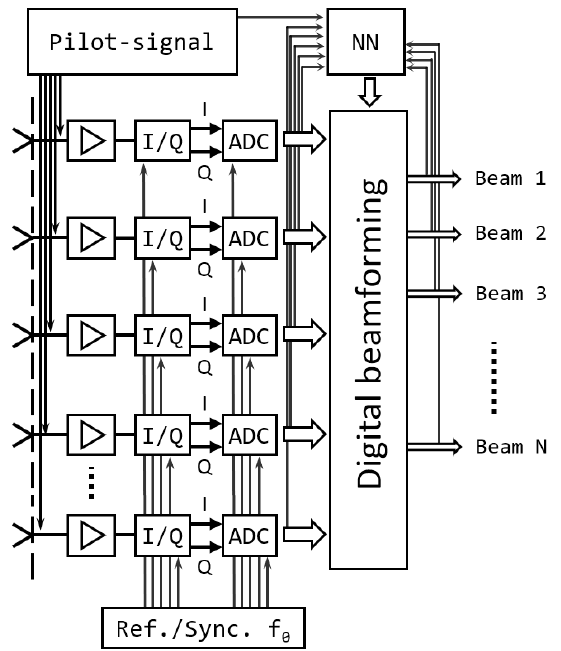
Fig. 1. Structure of digital array with neural network guidance